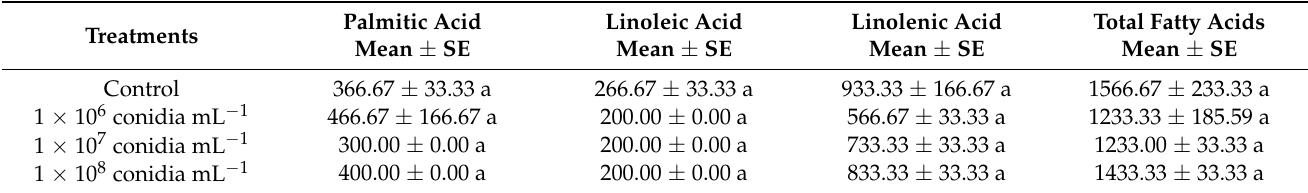
Table 8. Influence of Beauveria bassiana on proximate composition of Lactuca sativa (mg kg − 1 ) ( n = 12). Treatments